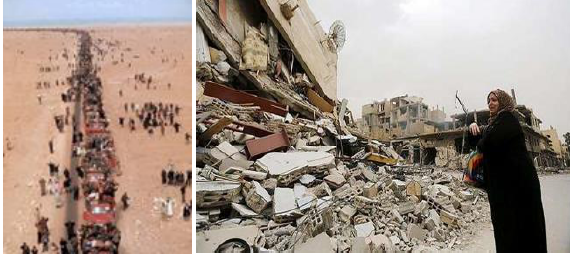
Figure(46) fleeing out sid the city, Figure(47) distruction in the modern